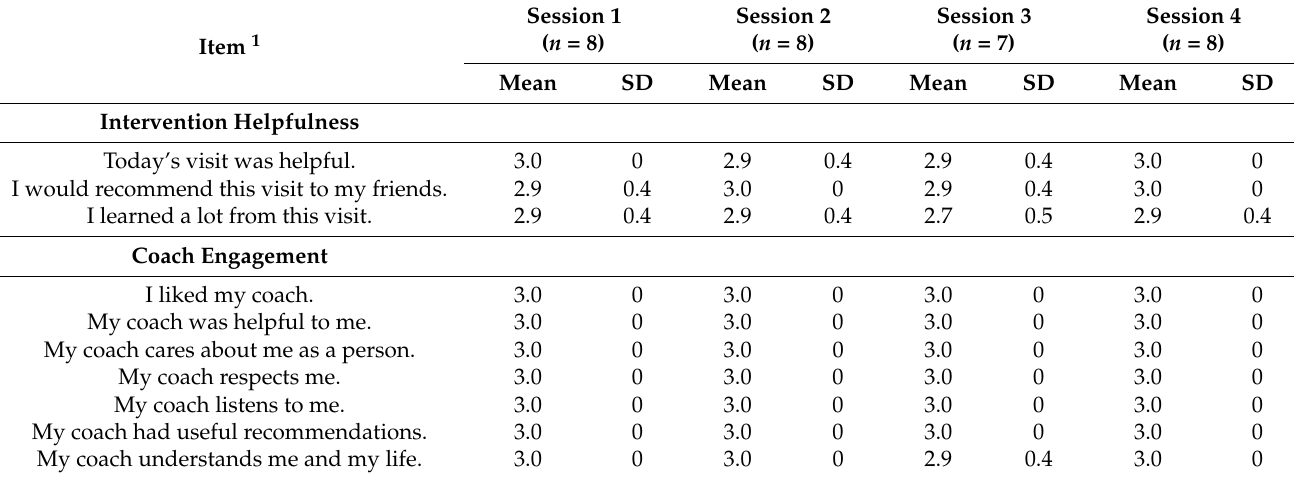
Table 3. Mothers’ responses to session helpfulness and coach engagement